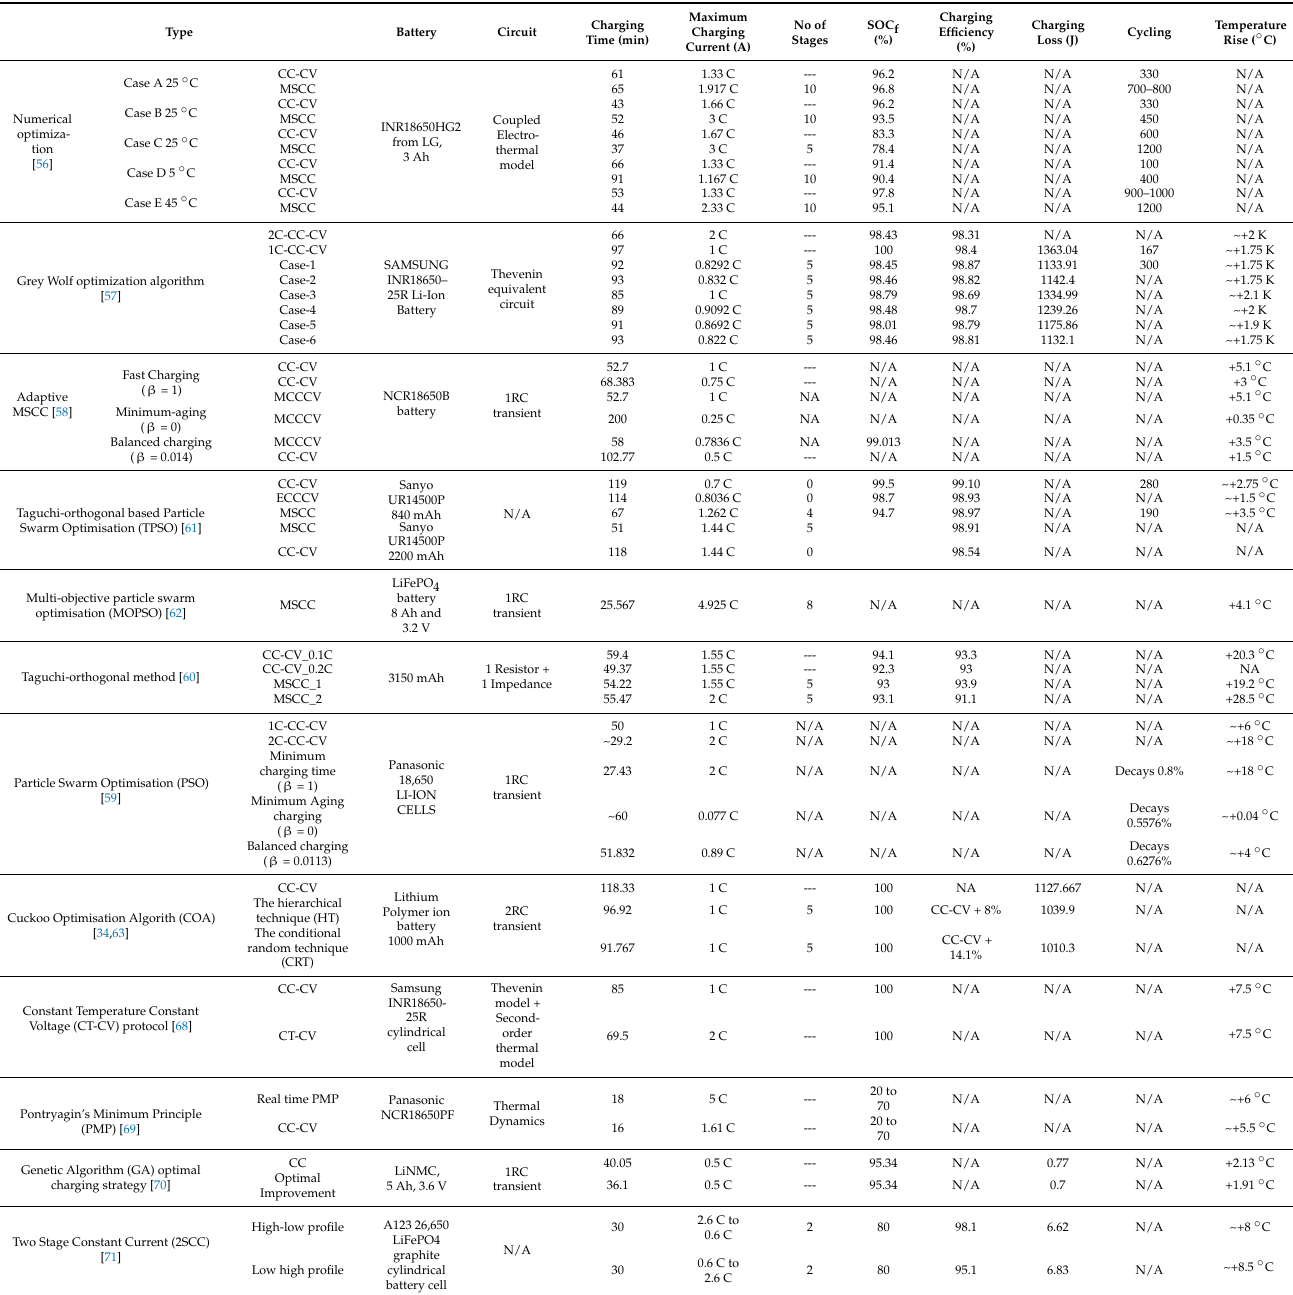
Table 2. Comparison between algorithms presented in the literature survey using the Multi-stage charging current (MSCC) protocol, and Thermal Management